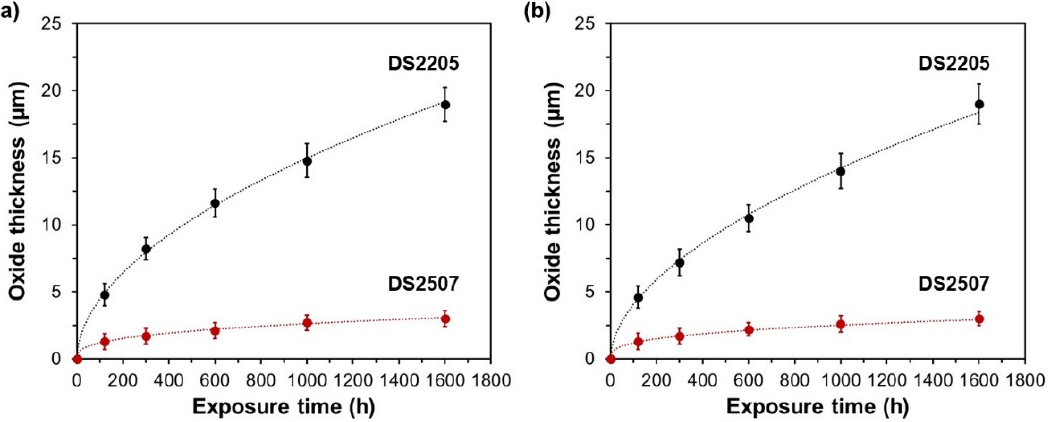
Figure 1. Evolution of oxide scale thickness formed on DS2205 and DS2507, as a function of the exposure time determined using: ( a ) optical microscopy, and ( b ) Eddy current loss method. Table 2. Experimental parameters of Equation (1) after fitting the oxide thickness as a function of exposure time with each method for measuring of oxide thickness in the alloys. (*) Units of k ex-